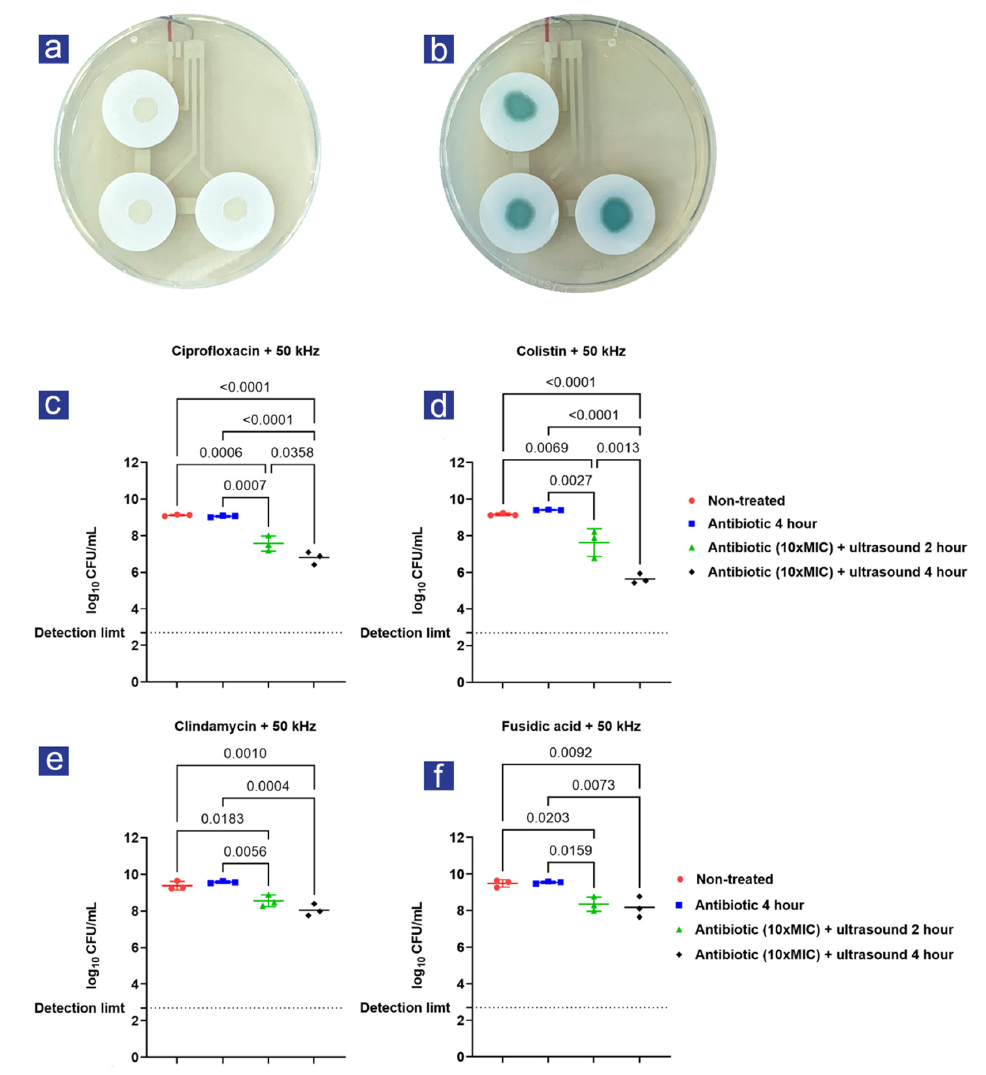
Figure 2. The combined effect of ultrasound and antibiotic treatment: ( a , b ) the final experimental setup with filter-biofilms of S. aureus (left) and P. aeruginosa (right) growing on the agar covering the ultrasound patches; ( c , d ) represent logarithmic-transformed colony-forming units per milliliter (Log10 CFU/mL) determined from P. aeruginosa filter-biofilms treated at 50 kHz for 2 and 4 hours in combination with ciprofloxacin and colistin, filter-biofilms treated with and without antibiotics served as controls; ( e , f ) represent Log10 CFU/mL determined from S. aureus filter-biofilms treated at 50 kHz for 2 and 4 hours with clindamycin and fusidic acid. Filter-biofilms treated with and without antibiotics served as controls. N = 3 for all experiments, and bars represent SD. Statistical tests were performed using one-way ANOVA; only significant differences ( p < 0.05) are shown.